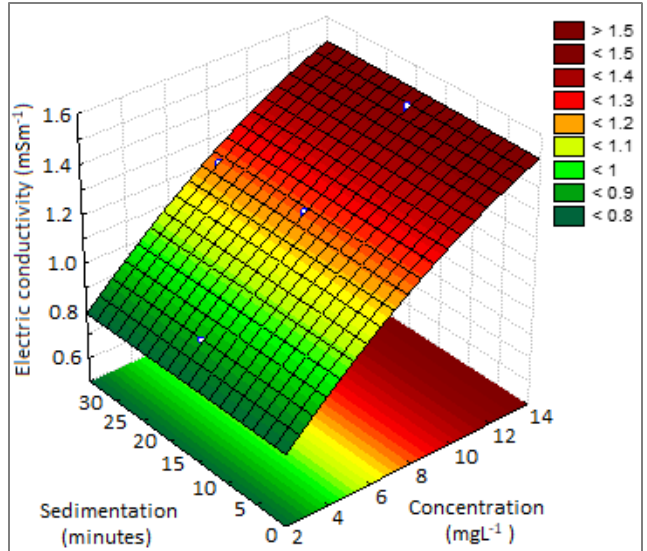
Figure 4. Electrical conductivity surface graph for the treatment with Moringa oleifera associated with the magnetite nanoparticle.